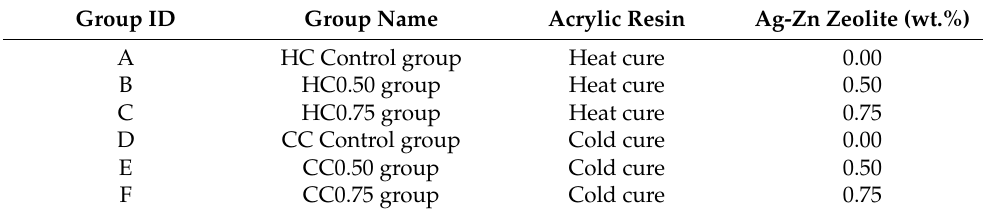
Table 1. Material groups used in the